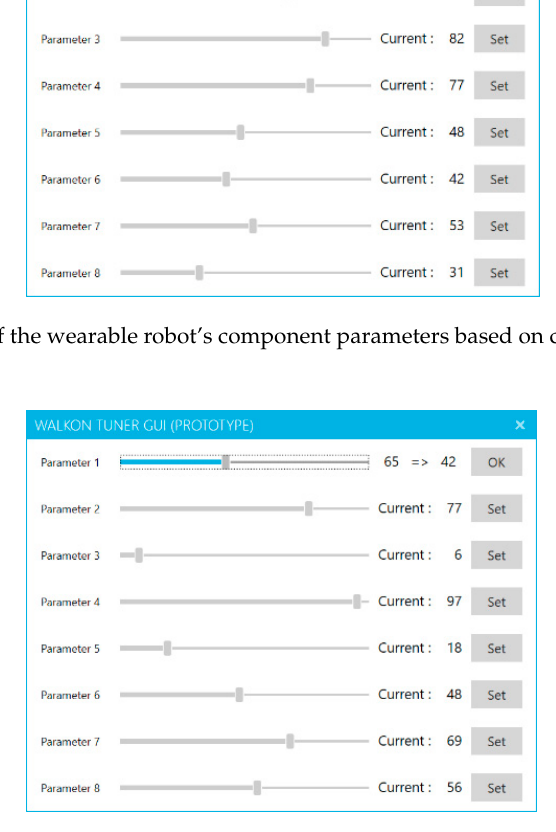
Figure 6. Adjustment of the wearable robot’s component parameters based on the results of the component-processing module.